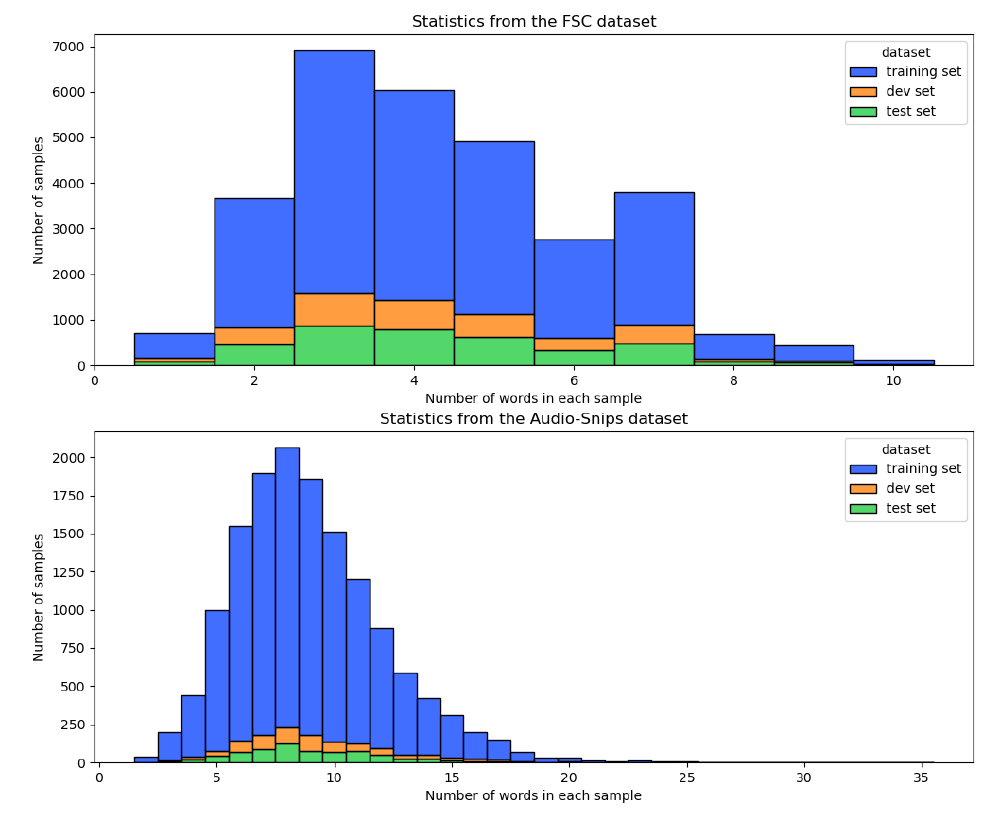
Figure 2. Distribution of words per sample in the FSC and the Audio-Snips